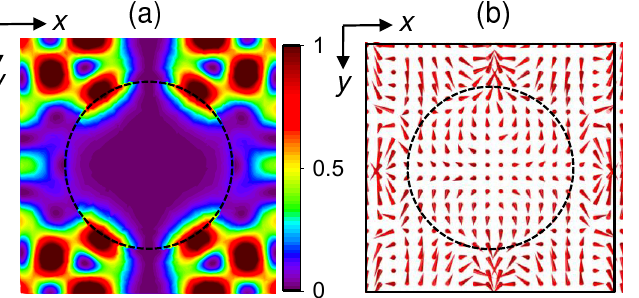
Figure 2. Lateral distribution maps of ( a ) the electric field intensity and ( b ) the Poynting vector in the ( x , y ) plane in photodetectors with nanostructured surfaces. The hole array parameters are d = 930 nm and p = 1400 nm. The data were taken at the distance of 105 nm below the device surface. The boundary of the hole is drawn by the dashed line. Arrows indicate the directions of the Poynting vector. The structure was illuminated from the substrate side with a plane-wave light at 1.6 µ m polarized in the x direction. The simulated region is a unit cell of hole-array structure. Excitation of the guided lateral modes concentrated outside the hole is